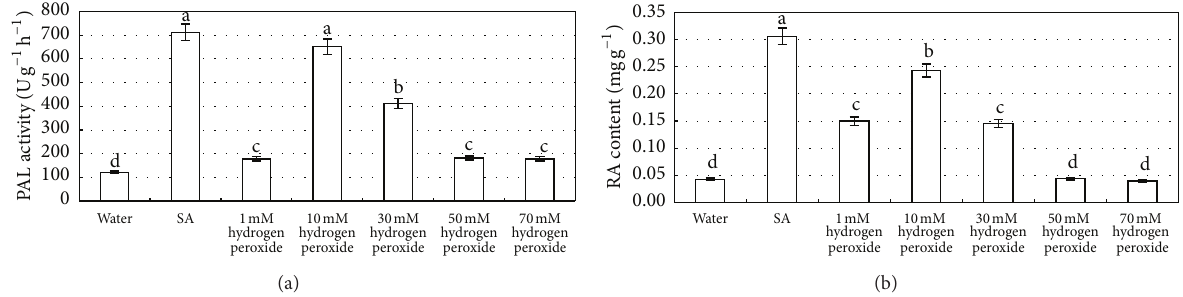
Figure 2: Effects of exogenous hydrogen peroxide with different concentrations on PAL activity (a) and RA accumulation (b) in the S . miltiorrhiza suspension cultured cells. The salicylic acid concentration is 22.5 mg/L. Values are means of three independent experiments. Bars represented standard errors. Different lowercase letters represent the significant differences between PAL activity (a) and RA content (b) after each treatment at the level of